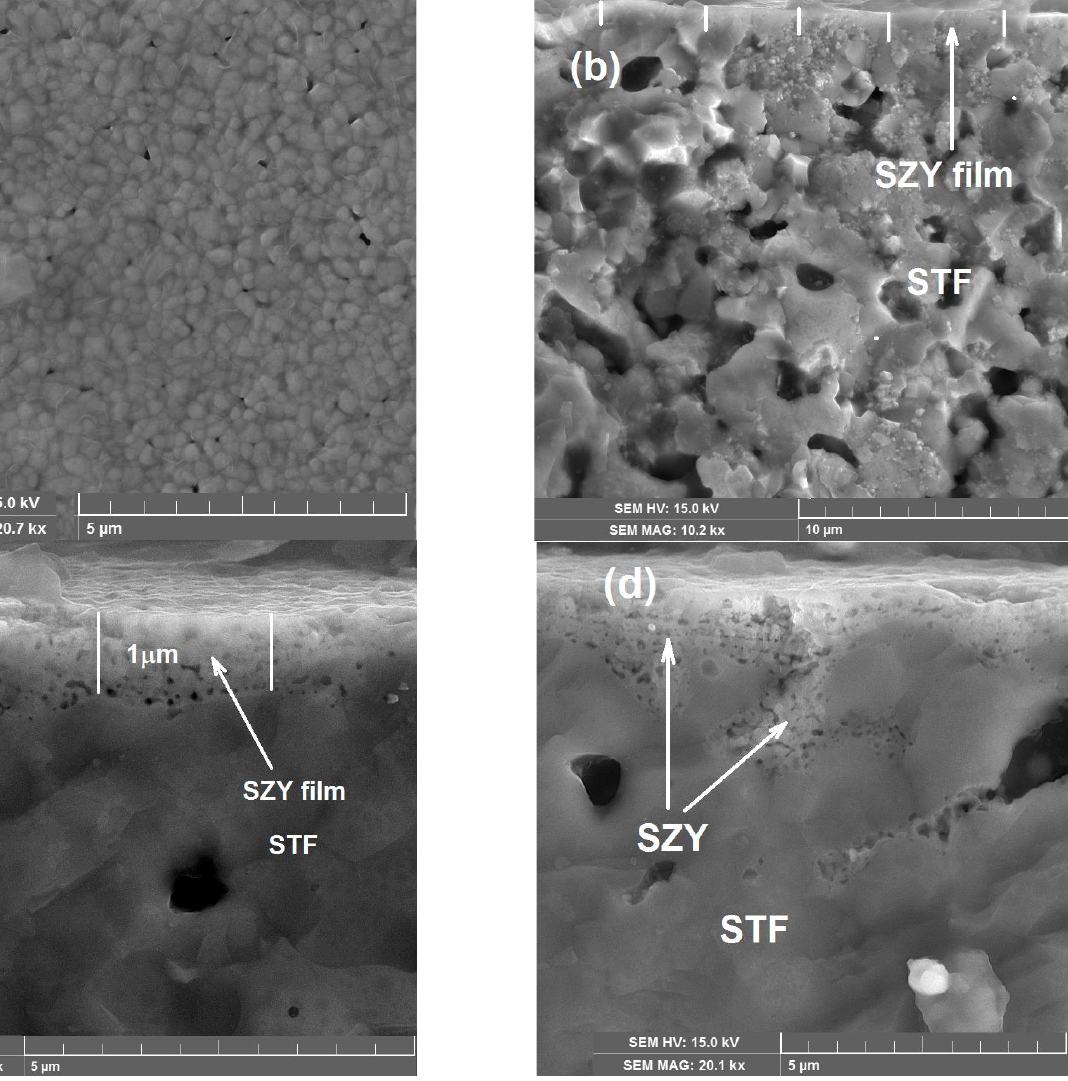
Figure 5. SEM-images of the surface ( a ) and the cross section of SZY films deposited on STF sub- strates by ( b ) 25 dip-coating/annealing cycles and ( c,d ) 30 dip-coating/annealing cycles. by ( b ) 25 dip-coating/annealing cycles and ( c , d ) 30 dip-coating/annealing